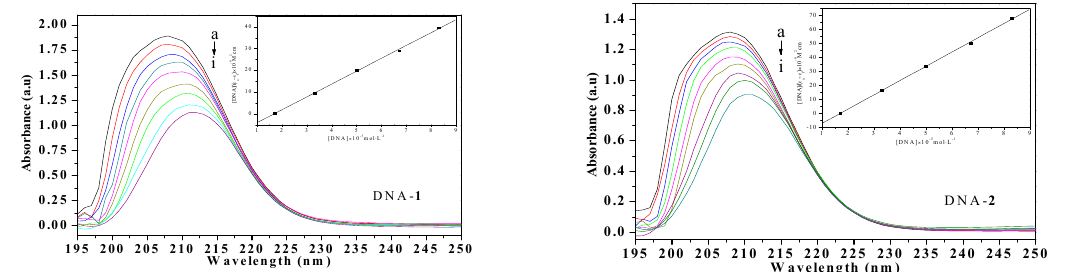
Figure 3. Absorption spectra of HL1, HL2, 1 and 2 (1.0 × 10 − 7 mol · L − 1 ) in the absence and presence of increasing amounts of CT-DNA (from a to i) at room temperature. The arrow shows the absorption changes on increasing CT-DNA concentration. Insert: Plot of [DNA]/( ε a − ε f ) versus [DNA] for absorption titration of CT-DNA with the compound.